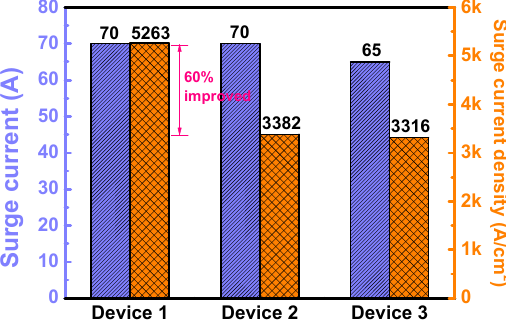
Figure 10. The surge current capability (left axis) and surge current density capability (right axis) of the three devices.